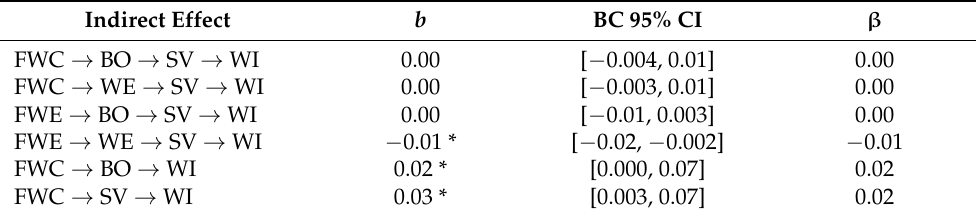
Table 3. Indirect Effects of Family-to-Work Interface on Workplace